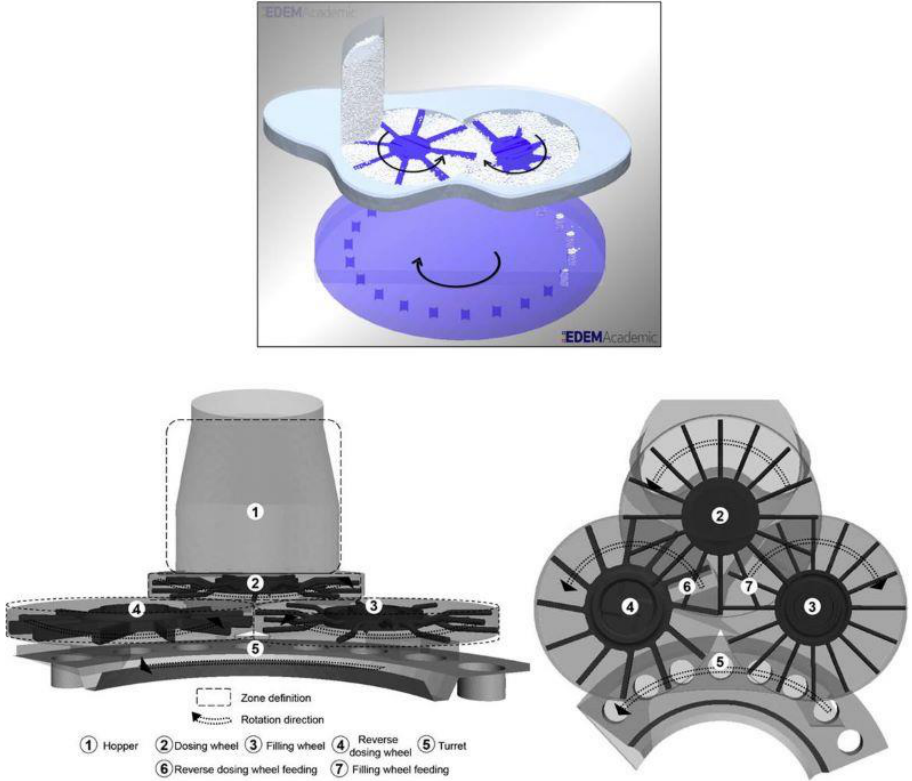
Figure 8. ( Top ): Schematics of a two-paddle feed frame. Adapted with permission from [69]; published by Elsevier, 2014. ( Bottom ): Schematics of three-paddle Fill-O-Matic feed frame. Adapted with permission from [71]; published by WILEY-VCH Verlag GmbH & Co. KGaA, 2018. Mendez et al. compared the shearing fragmentation and particle size distribution change between a two-paddle feed frame (Manesty press type) and a three-paddle wheel frame (Fette Fill-O-Matic) at different paddle and die disk speeds. The latter consisted of a dosing wheel in the upper section, and reverse-dosing and filling wheels in the lower frame section, with paddles of different geometries (Figure 8, bottom). Based on the